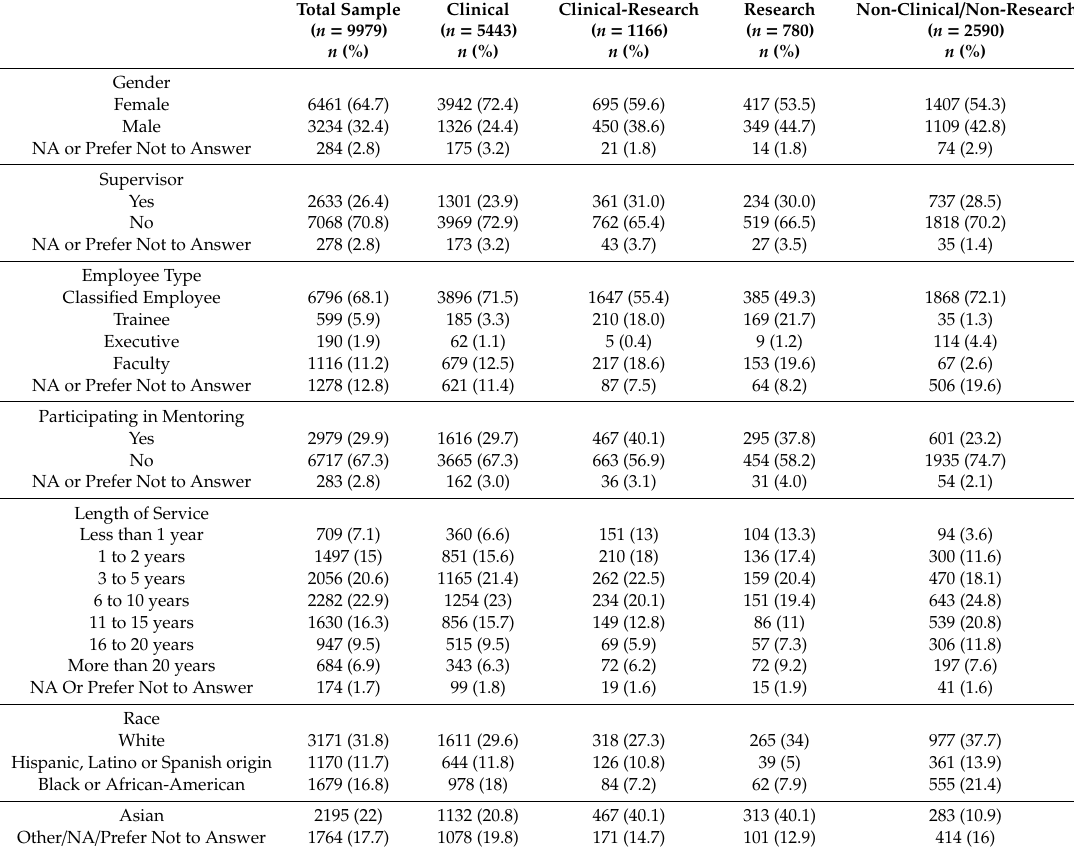
Table 1. Demographic characteristics by department